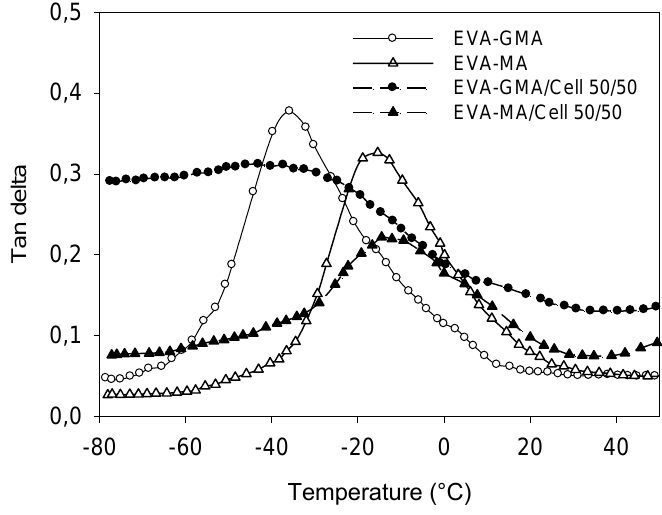
Figure 16. Temperature dependence of tan  values for EVA-GMA, EVA-MA and composites with